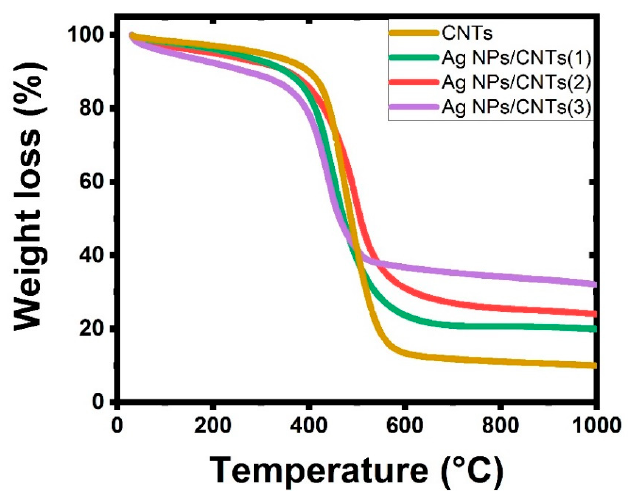
Figure 6. TGA of the used CNTs and their decoration by Ag NPs with different concentrations based on tuning laser ablation time.